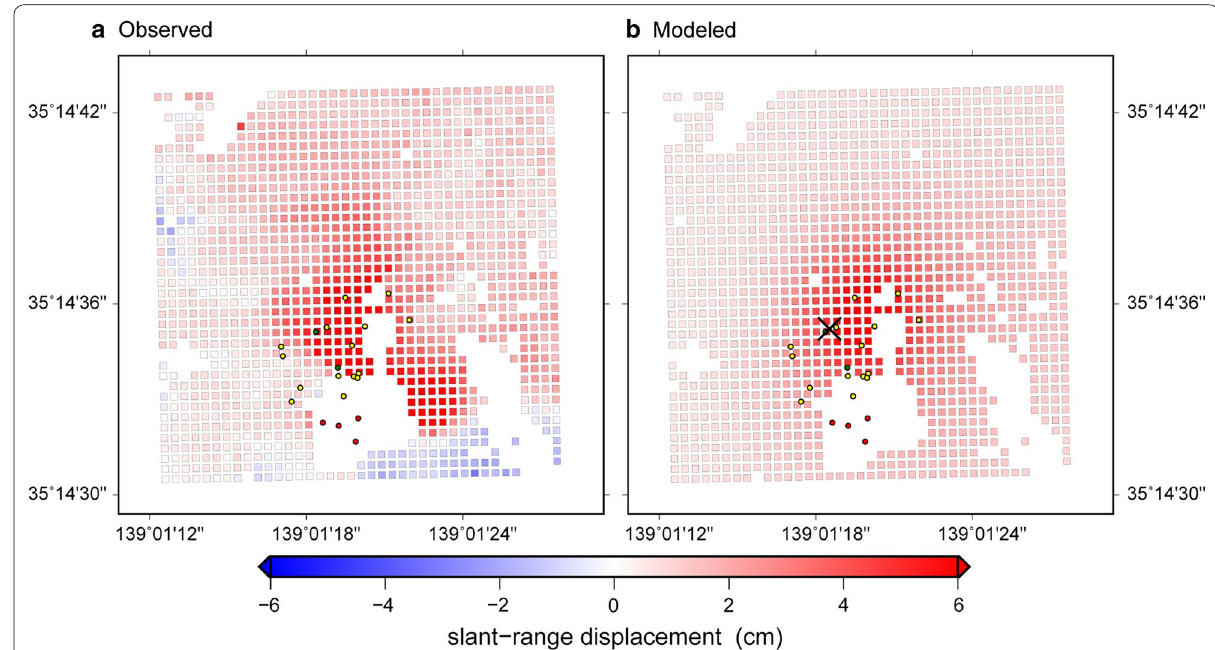
Fig. 8 Result of the inversion estimating the point pressure source beneath the Owakudani. a Subsampled displacement data of Pair I prepared for the inversion. b Modeled surface displacement. Offset parameter was 5.34 mm. RMS of the residual between observation and model was 1.19 cm (RMS of the original dataset was 2.34 cm). Green circles show the steam wells that experienced abnormal blowout during the 2015 unrest. Red and yellow circles show the newly formed craters and fumaroles, respectively. The “X” mark shows the location of the estimated point pressure source, the parameters of which are listed in Table 4